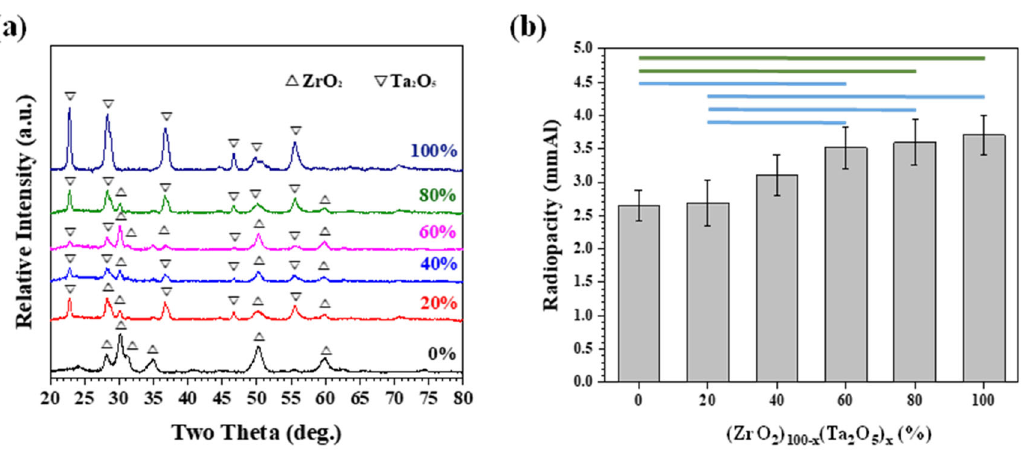
Figure 5. ( a ) X-ray diffraction patterns of as-milled (ZrO 2 ) 100-x (Ta 2 O 5 ) x powder and ( b ) corresponding radiopacities of as-prepared MTA-like cements. The horizontal green and blue lines indicated that the paired results are statistically different at a confidence level of 99 and 95%,